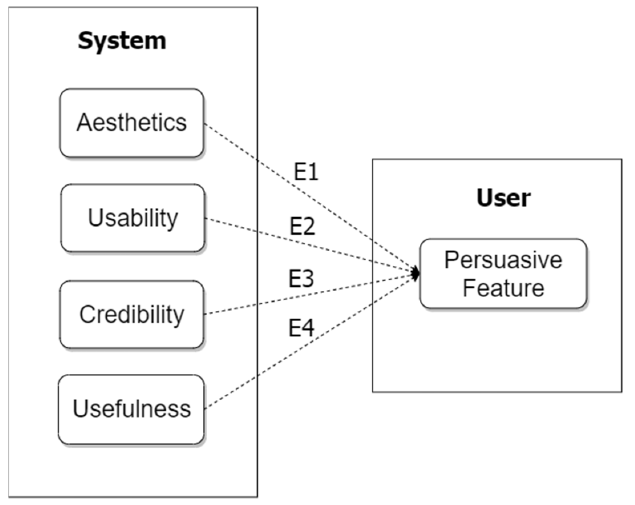
Figure 2. Exploratory research model.